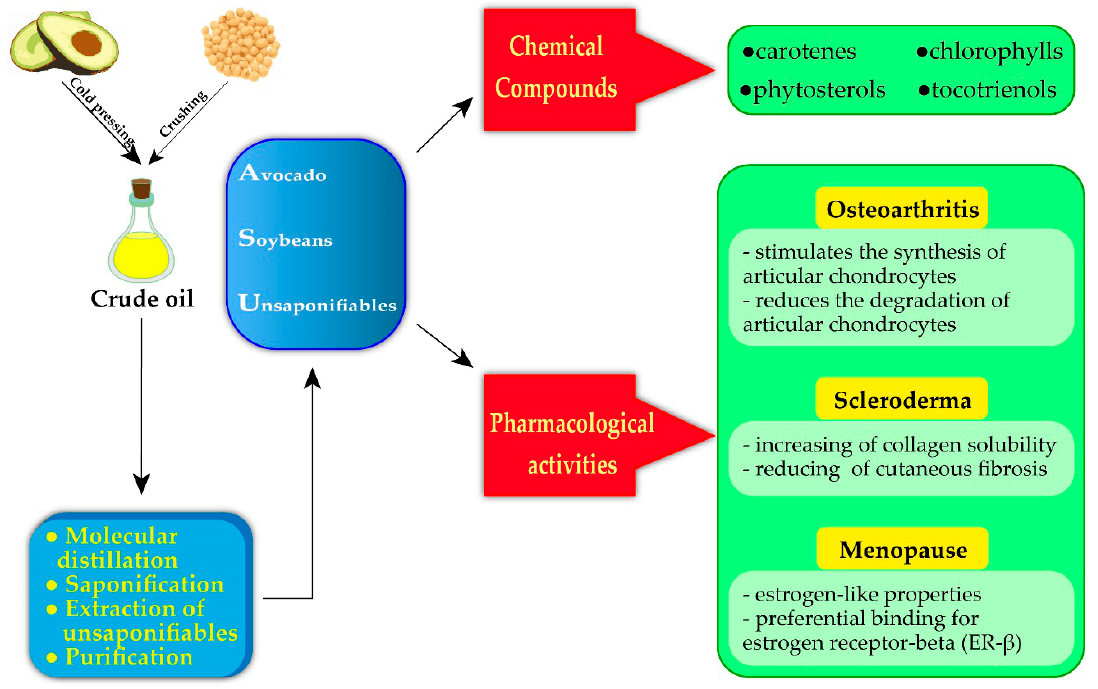
Figure 2. Extraction of ASU, chemical composition and the main pharmacological activities for human health.